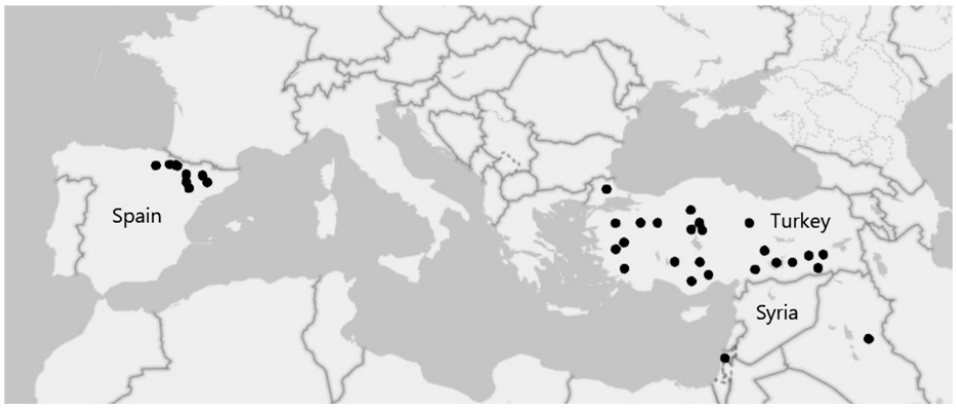
Figure 1. Map showing the location of the 57 Brachypodium distachyon accessions used in this re-